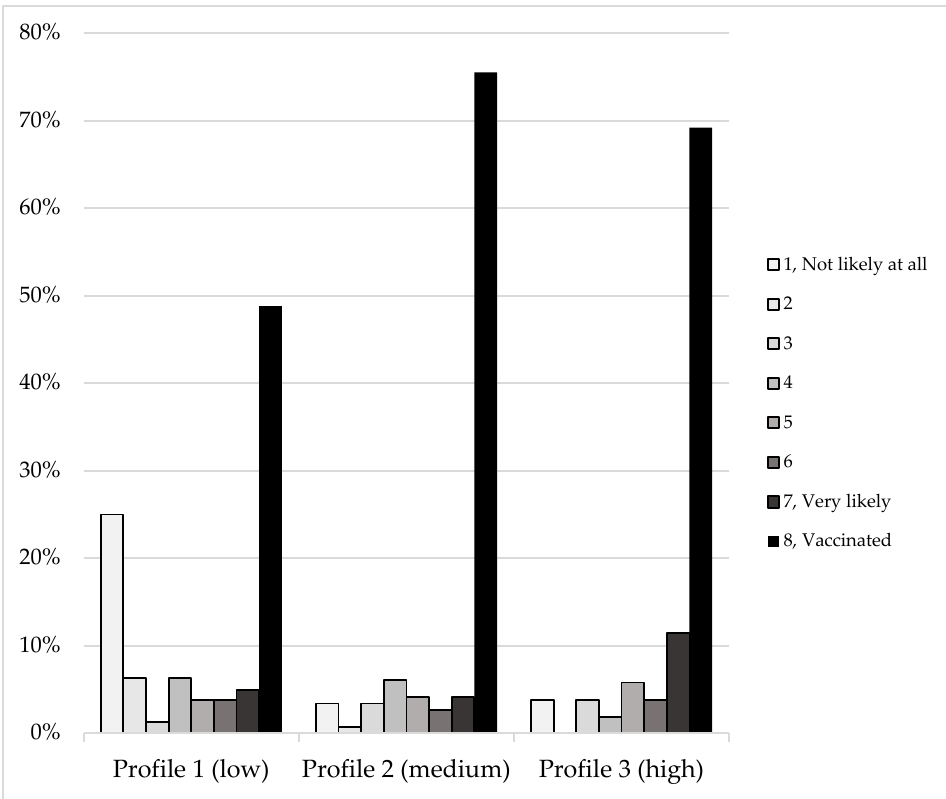
Figure 2. Vaccination willingness scores as proportions (%) by trust profile. Note: All percentages use the profile group’s size as denominator; Profile 1 ( n = 80), Profile 2 ( n = 147), Profile 3 ( n = 52).